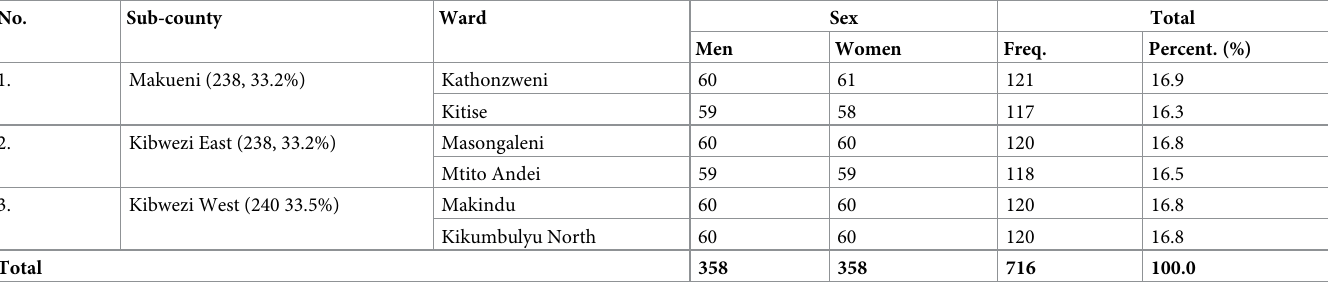
Table 1. Survey respondents disaggregated by administrative sub-counties, wards and gender.